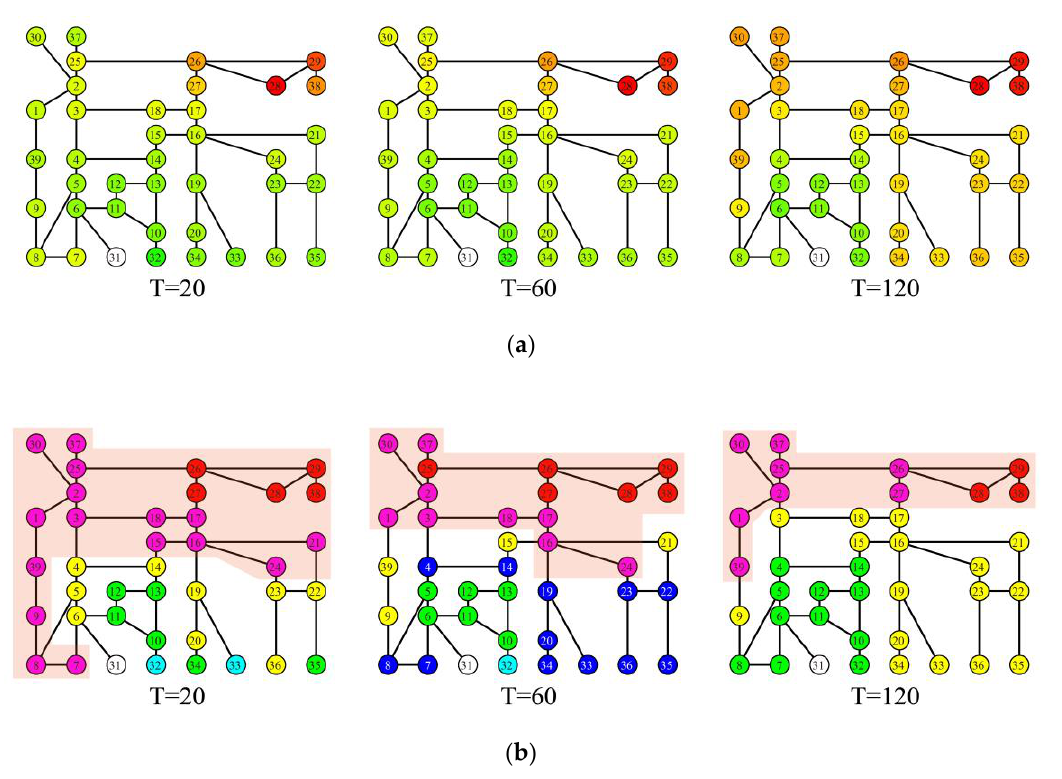
Figure 6. Dynamic critical nodes and regions identification results for case B. ( a ) The critical nodes; ( b ) the critical regions. Table 2. Top 10 critical nodes with their importance score in case